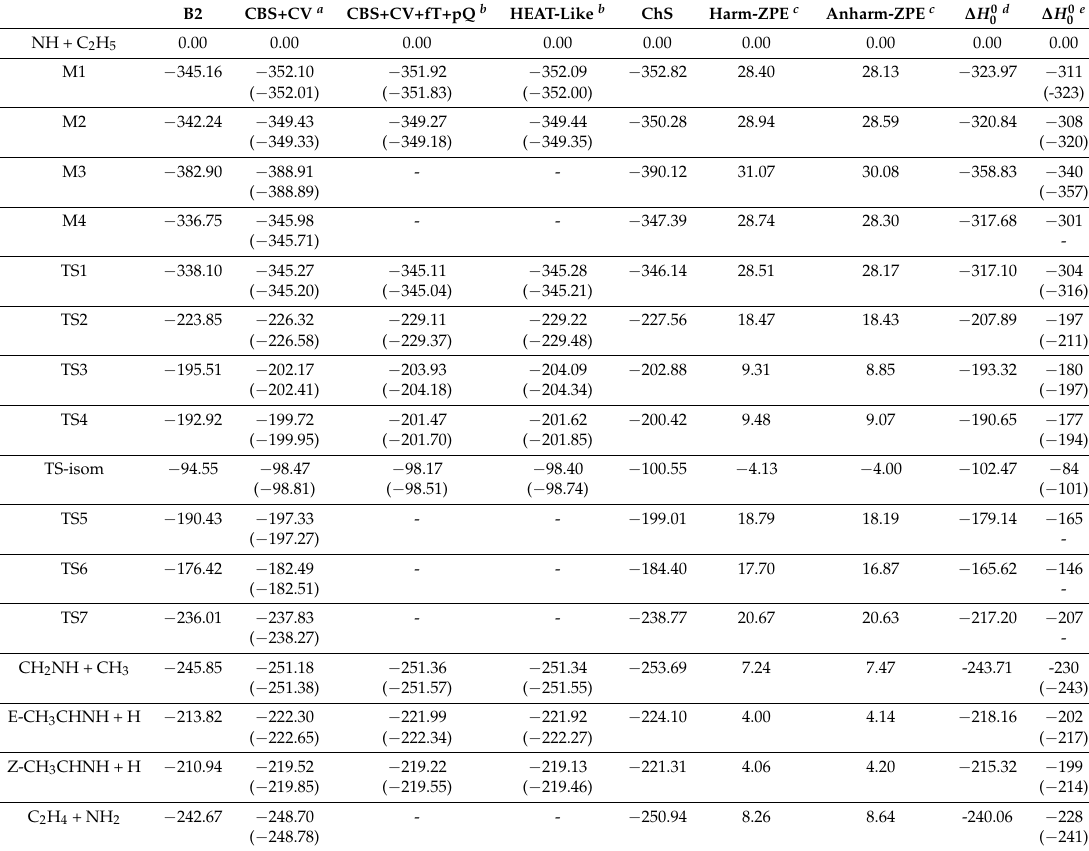
Table 1. Relative electronic energies together with ZPVE corrections. Values in kJmol − 1